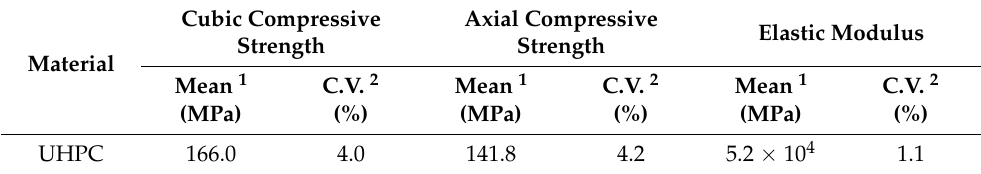
Table 3. Compressive properties of UHPC.